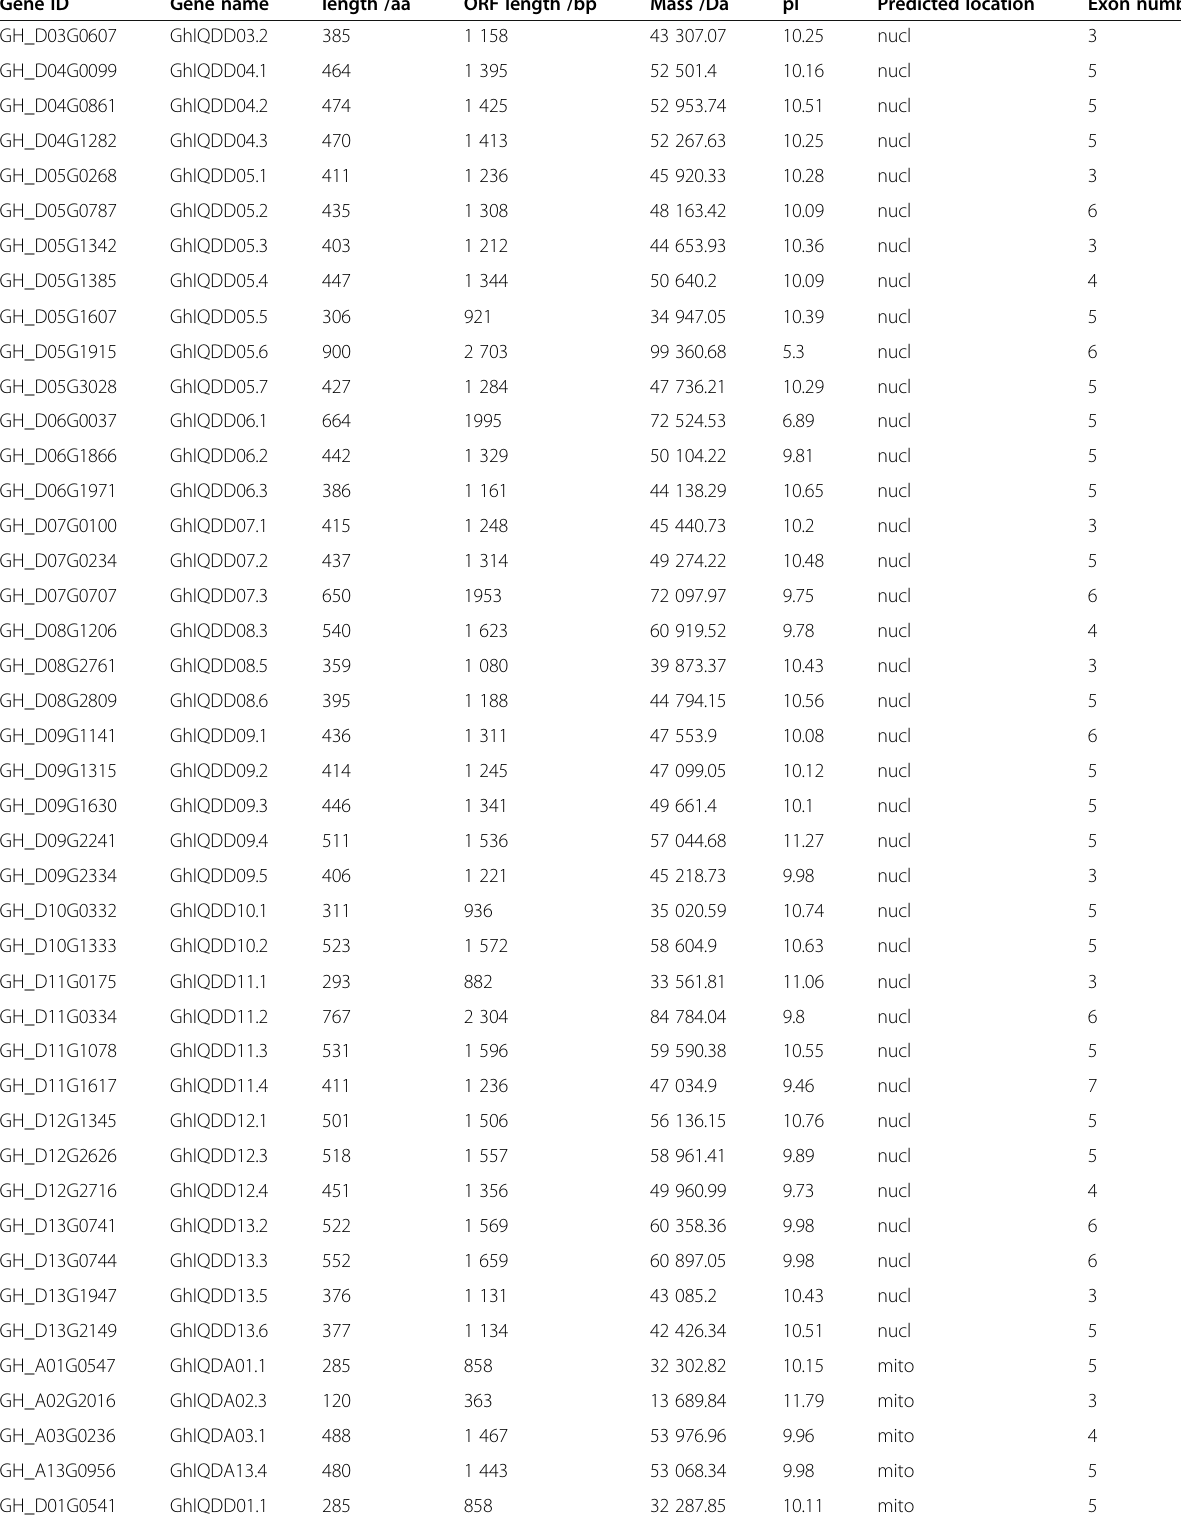
Table 1 Information of GhIQD gene family members in G.hirsutum L., their sequence characteristics and subcellular location (Continued) Gene